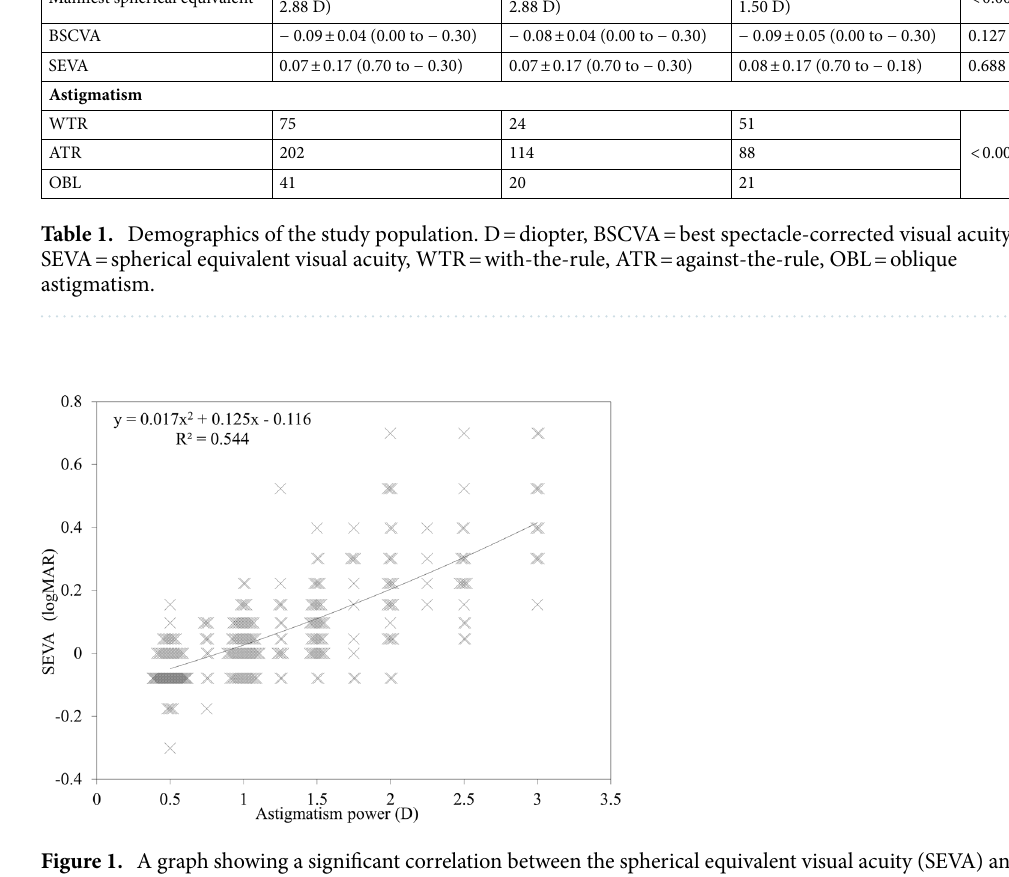
Figure 1. A graph showing a significant correlation between the spherical equivalent visual acuity (SEVA) and the amount of astigmatism in the entire study population (Spearman’s signed-rank test r = 0.715, p <